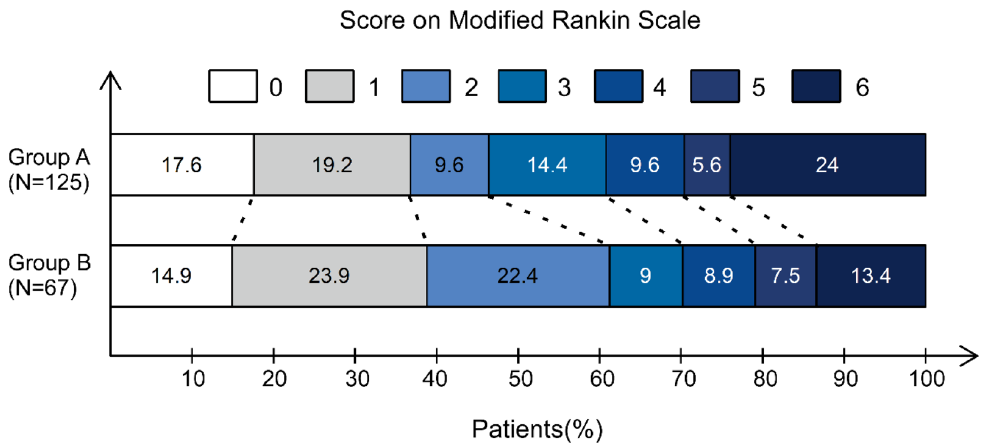
Figure 1. The modified Rankin scale scores at 90